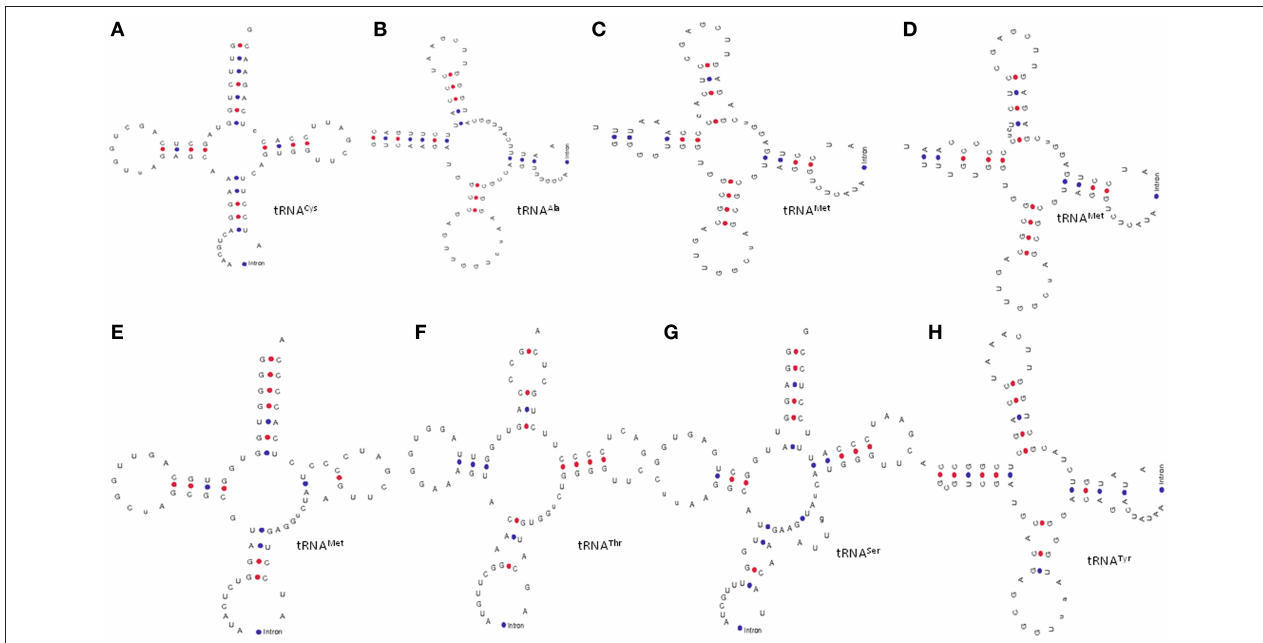
FIGURE 2 | General structures of intron containing tRNAs. Earlier it was reported that only tRNA Met and tRNA Tyr contains introns in higher plants. However, we found that (H) tRNA Tyr ; (G) tRNA Ser , (A) tRNA Cys , (F) tRNA Thr , and (B) tRNA Ala contain introns in additional to (C–E) tRNA Met . The introns in tRNA are usually found in the anti-codon loop. Adenine nucleotide is the predominant nucleotide before the start site of introns in all tRNA.